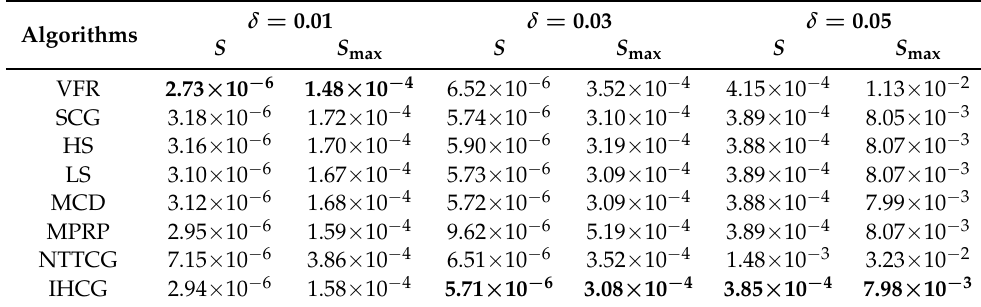
Table 3. Comparison under different error levels by different CG